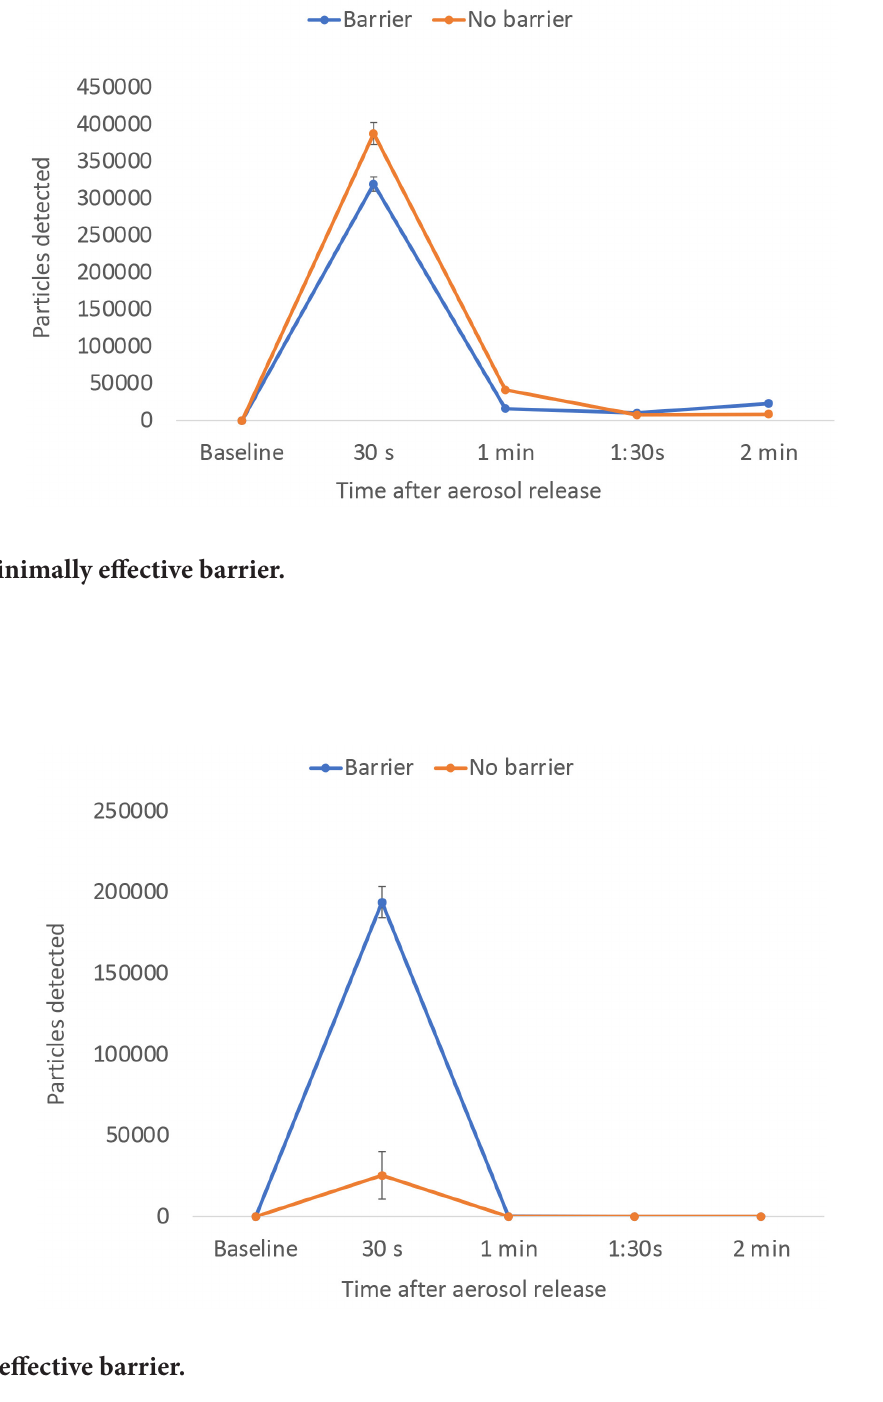
Figure 2C. Ineffective barrier. Figure 2. Number of 5% sodium chloride aerosol particles detected over 2 minutes with versus without a plexiglass barrier in place for 3 typical barriers, including an effective, minimally effective, and ineffective barrier. The aerosol particles were released at 91 cm from the barrier. Average results for 3 experiments are shown. Error bars represent standard